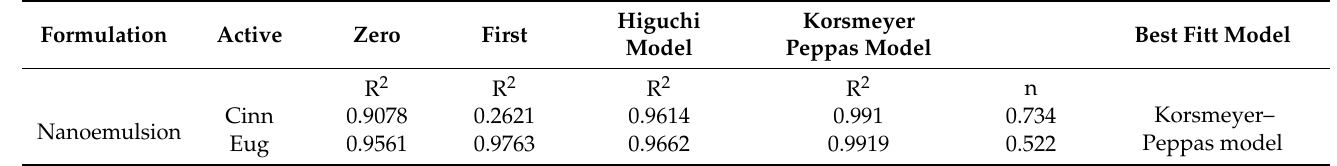
Table 14. Kinetic models application on formulated nanoemulsion.